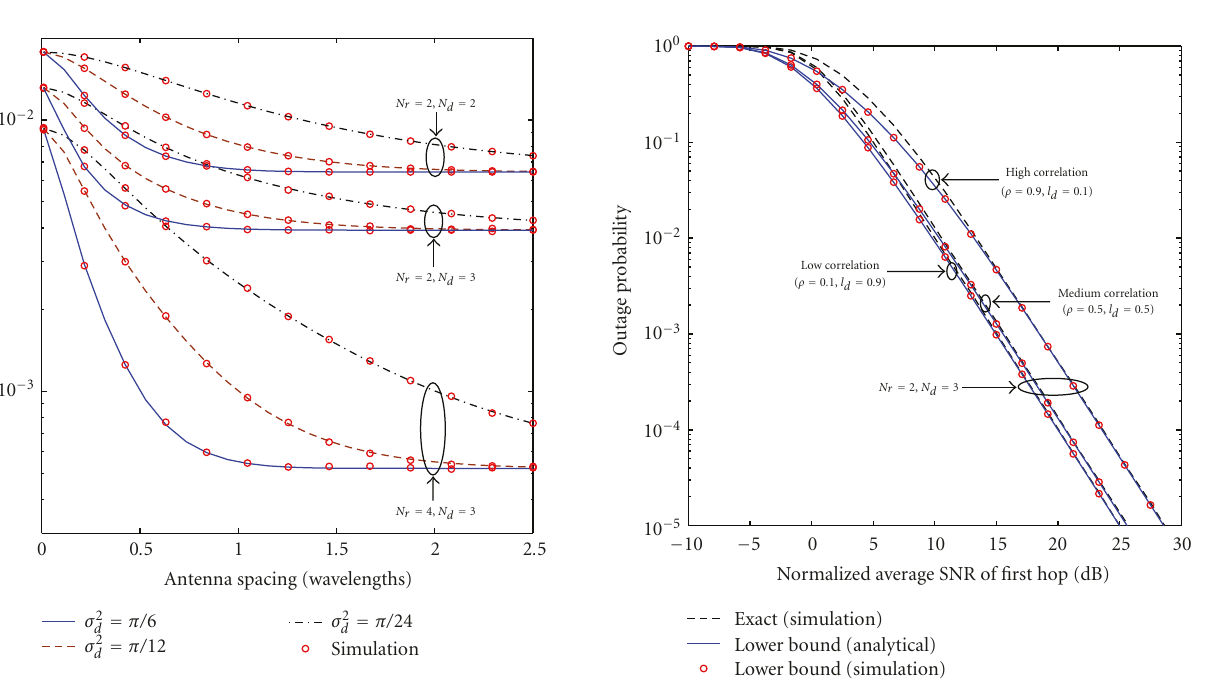
Figure 8: Outage probability of dual-hop MIMO relaying over correlated Rayleigh fading channels with two antennas at the relay and three antennas at the destination. γ = π/ 6. σ 2 d